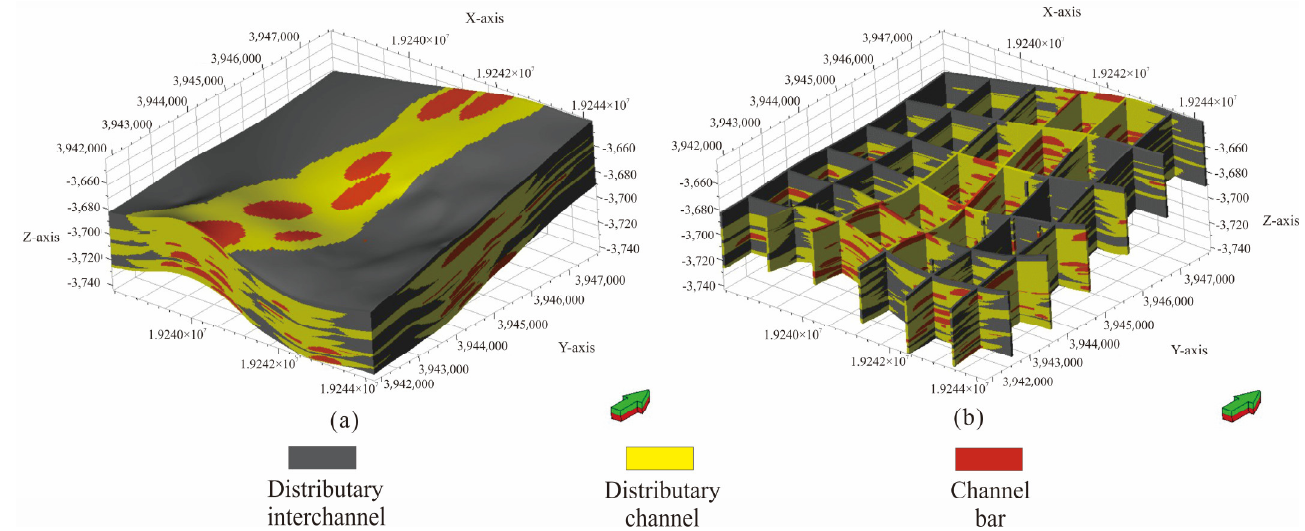
Figure 8. Simulation result of object-based method. ( a ) 3D model. ( b ) Grid model. For example, the parameter fitting in Table 2 calculates the variogram of different microfacies. Curve fitting is carried out for each bed, and the facies model is obtained after simulation (Figure 9).